Question: In a single sentence, describe what this figure presents.
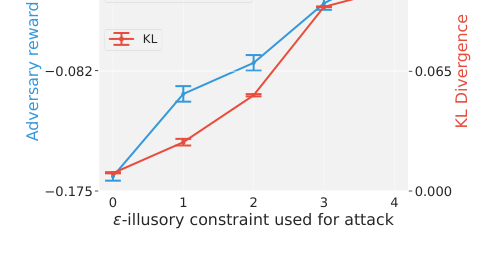
Answer: Empirical results for the 1-step MDP defined in Figure 2. The adversary’s expected return increases with increasing ϵ. At the same time, the empirical trajectory KL constraint tightly controls the adversary policy’s within ϵ detectability. The purple line indicates the ad- versary’s attack return ceiling at 0.0.